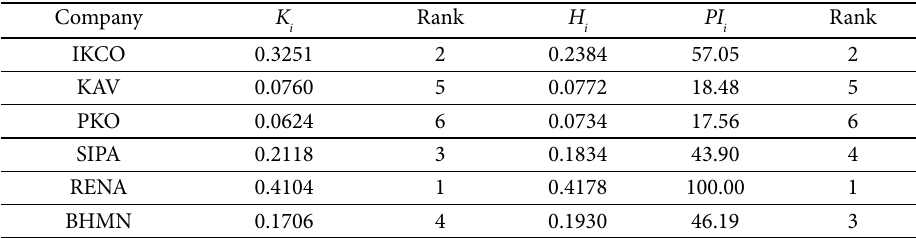
Table 7. The results of ARAS-F and fuzzy